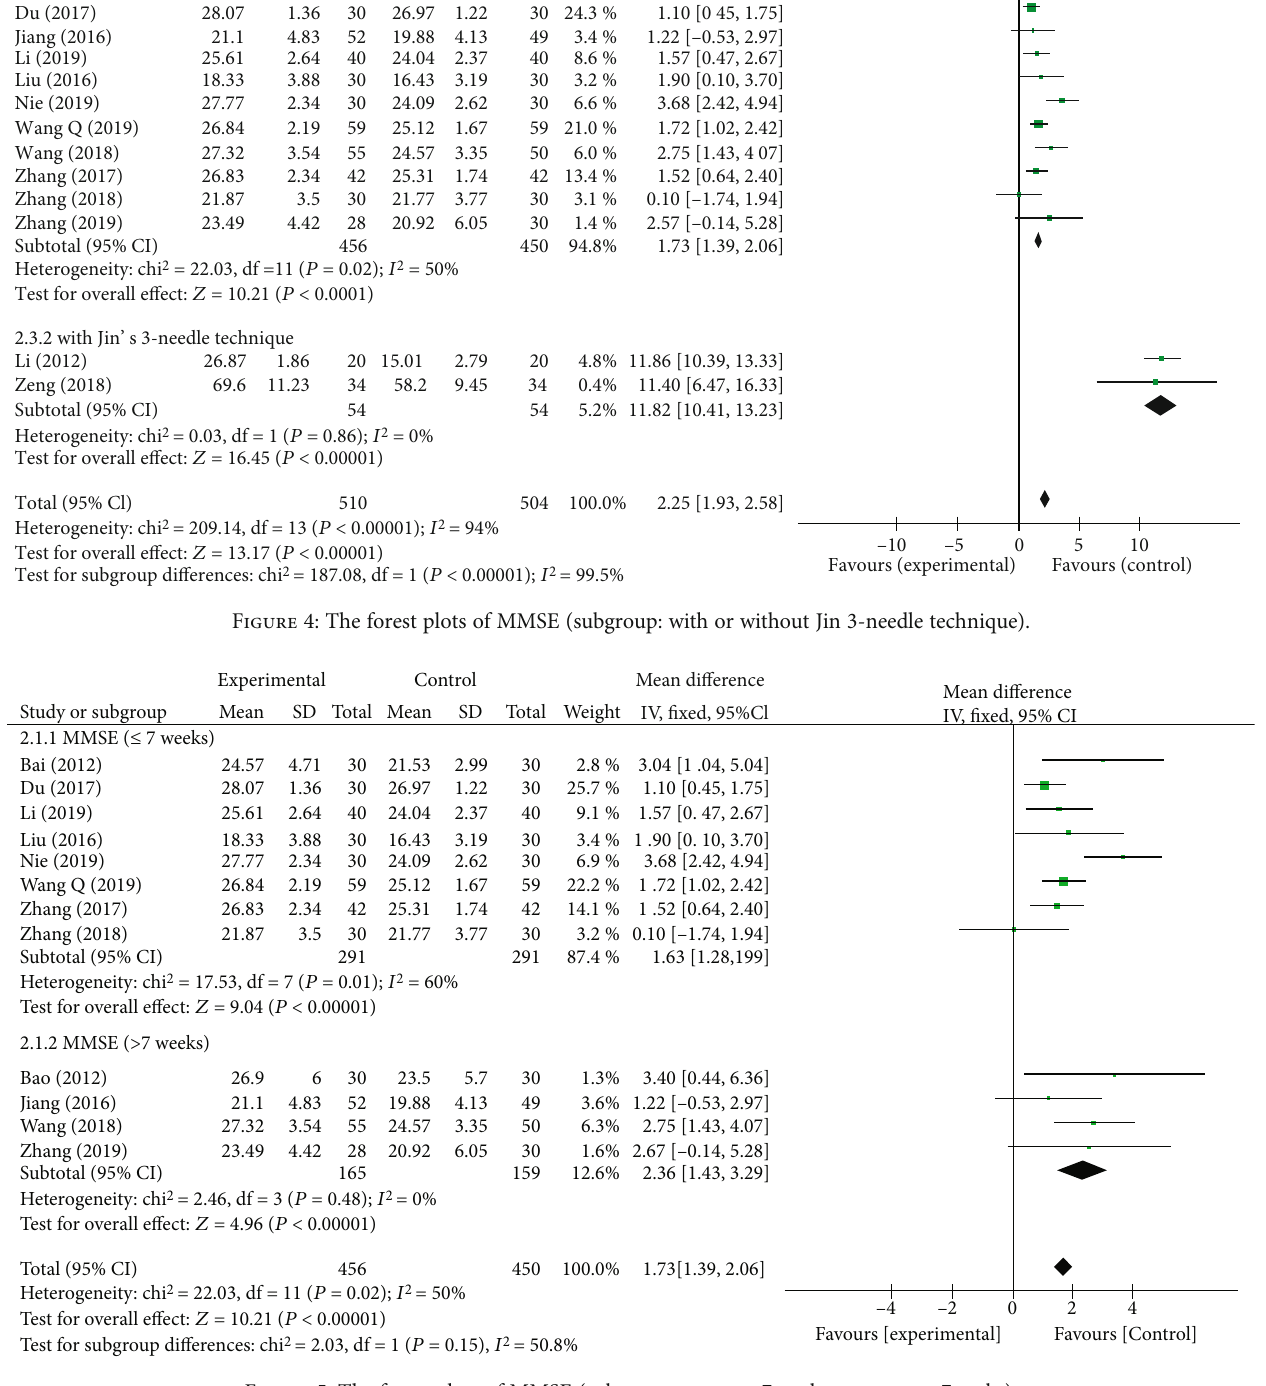
Figure 5: The forest plots of MMSE (subgroup: course ≤ 7weeks or course > 7weeks